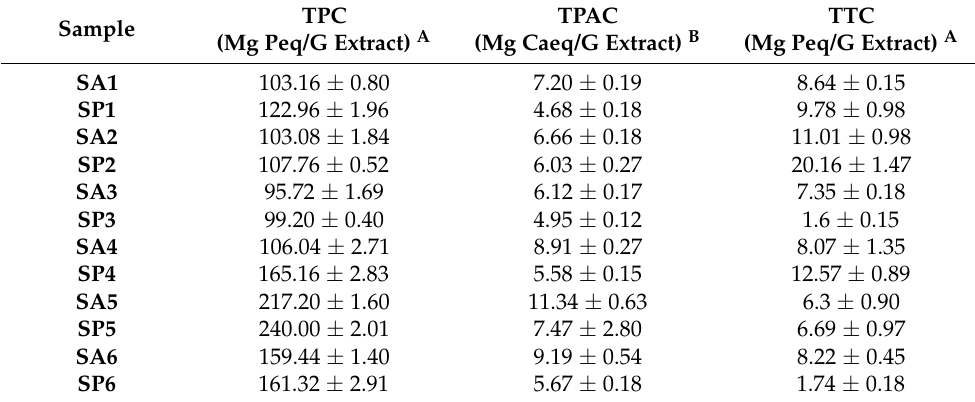
Table 2. Phytochemical analysis of total phenolic (TPC), phenolic acid (TPAC), and tannin contents (TTC) of SA1 – SA6 and SP1 – SP6